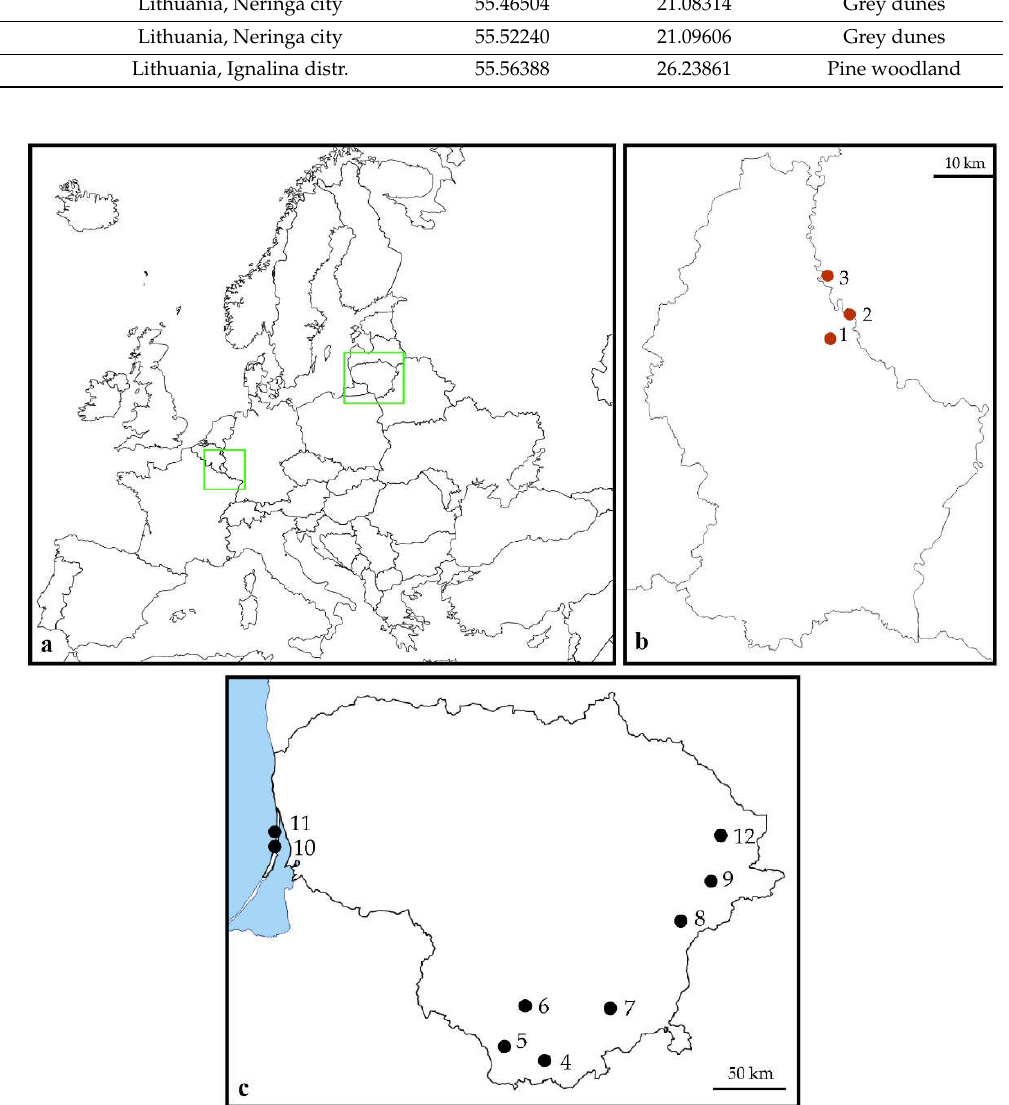
Figure 1. Cytisus scoparius study areas (green rectangles, ( a ) and locations of study sites in Luxem- bourg and Germany ( b ) and Lithuania ( c ). Red dots indicate survey sites in the native range and black dots in the invasive range. The numbering of the survey sites corresponds to the numbering in Table